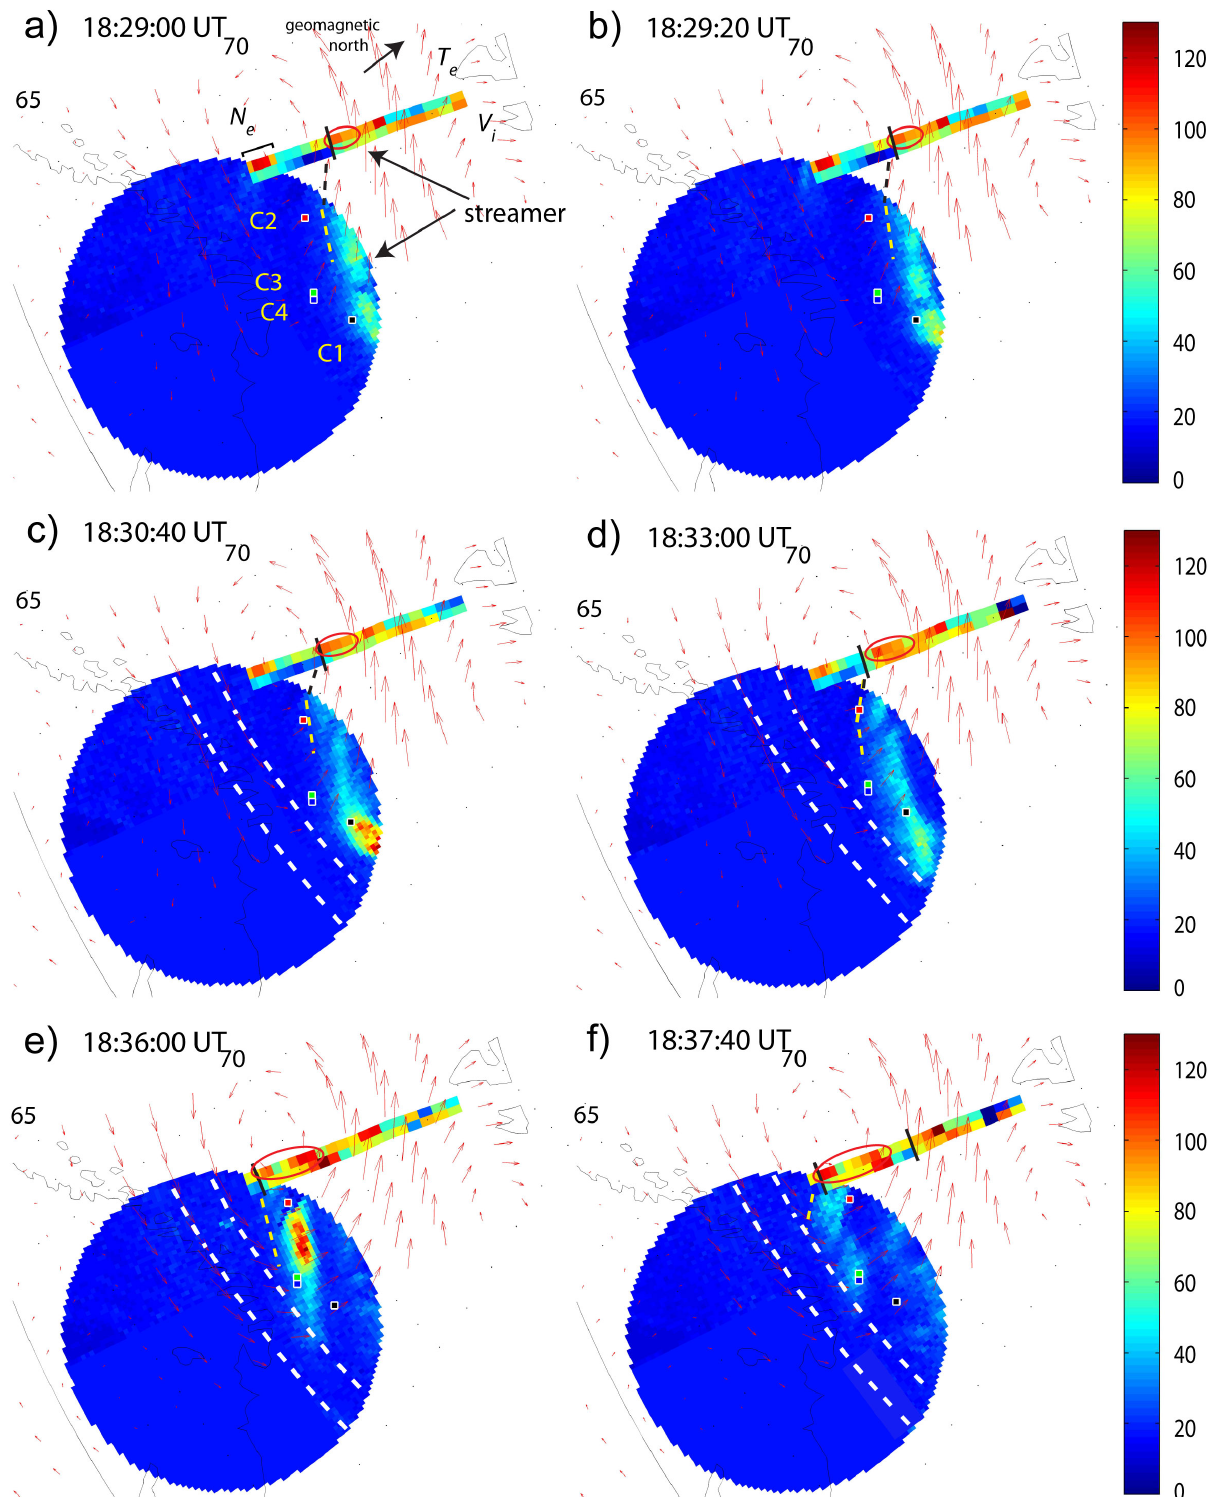
Fig. 8. A set of frames presenting the conjugate ground-based data during BBF flow event 2. The circle shows the KEV ASC data and the red arrows are the equivalent current vectors. The white dashed lines indicate the proton oval during the event. Coloured bars along the VHF radar beam are T e (replaced by N e at the nearest range gates), and V i . See details in the